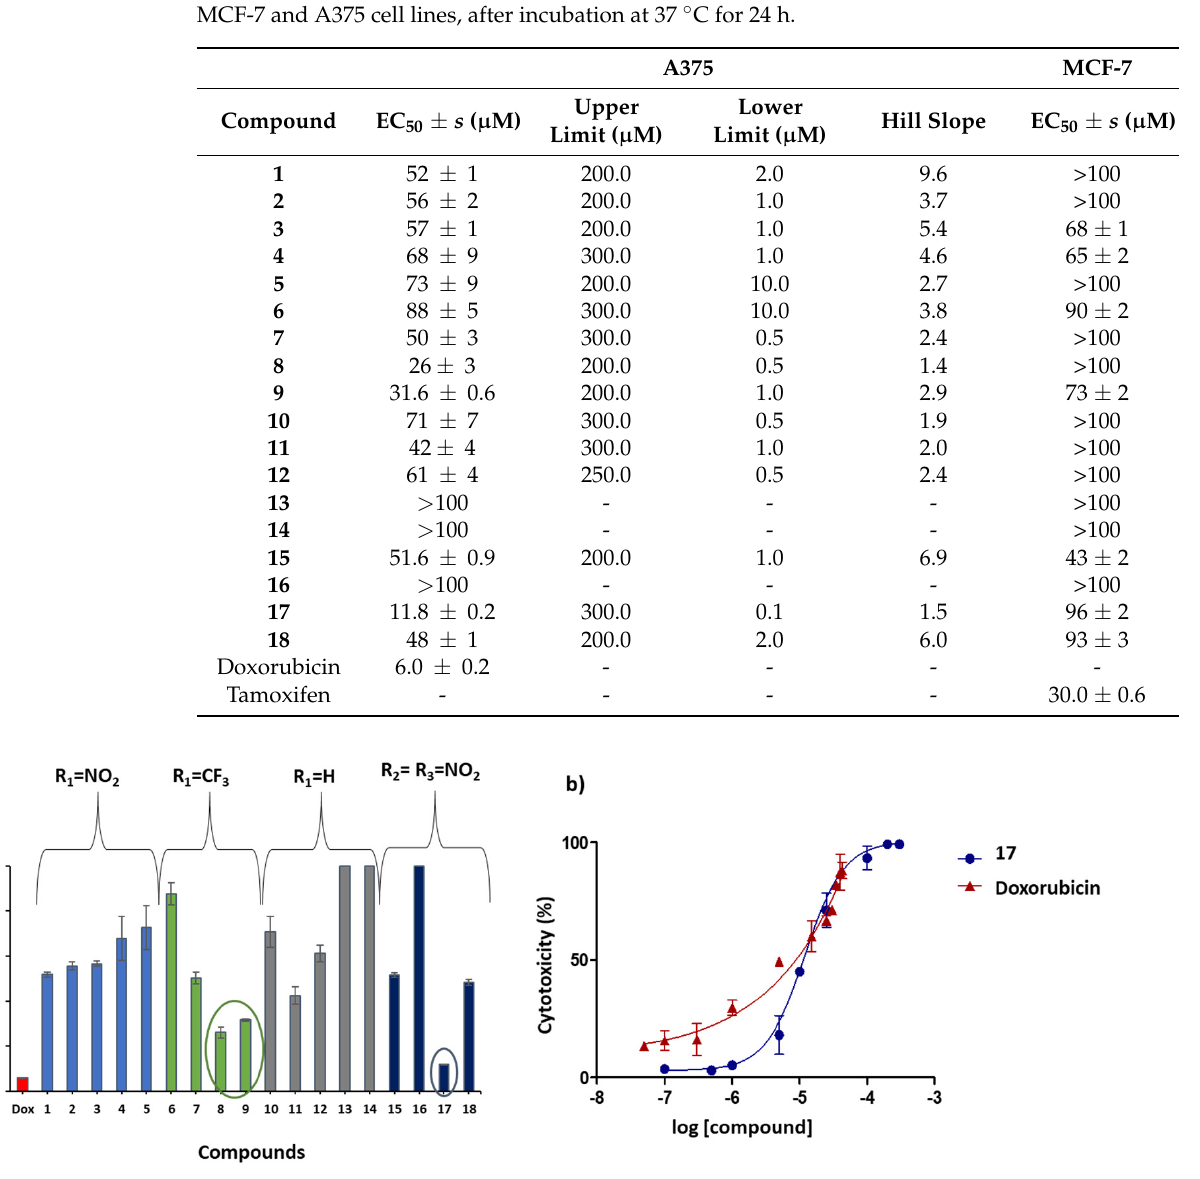
Figure 7. ( a ) Comparative compilation of all EC 50 for A375 cell line of the tested thiobenzanilides. The dark blue circle indicates the most promising thiobenzanilide derivative and the green circle refers to the two second-best compounds; ( b ) Dose–response curves for compound 17 and doxoru- bicin.